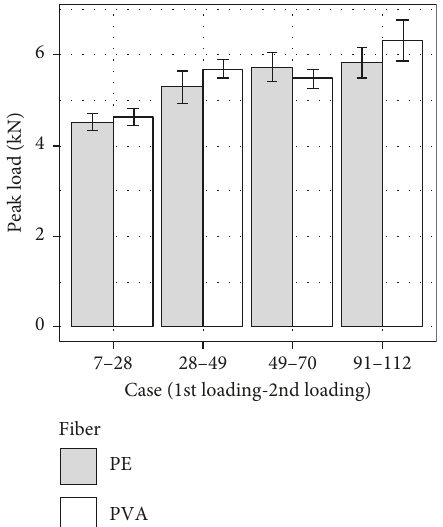
Figure 7: Peak load according to the 1st loading days.